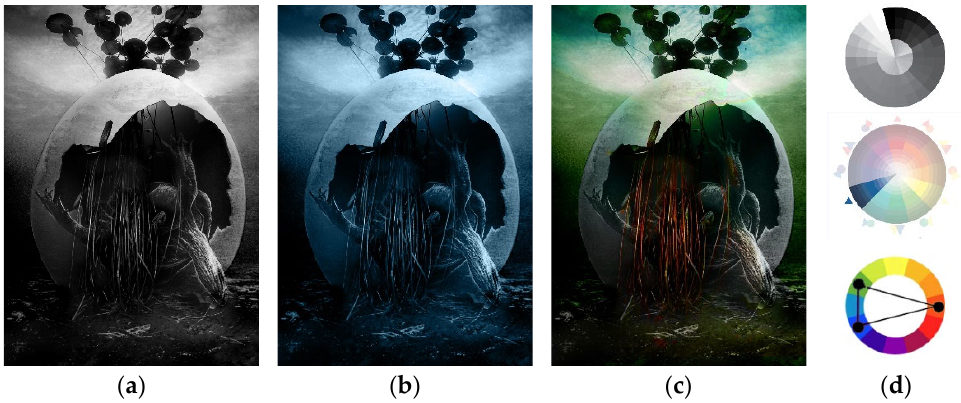
Figure 4. The turtle represents the sorrow and suffering caused by death, but the lotus leaf at the top uses the remains to regenerate: ( a ) Black-and-white concept; ( b ) Monochrome concept; ( c ) Color concept; ( d ) Color wheel concept of each image.